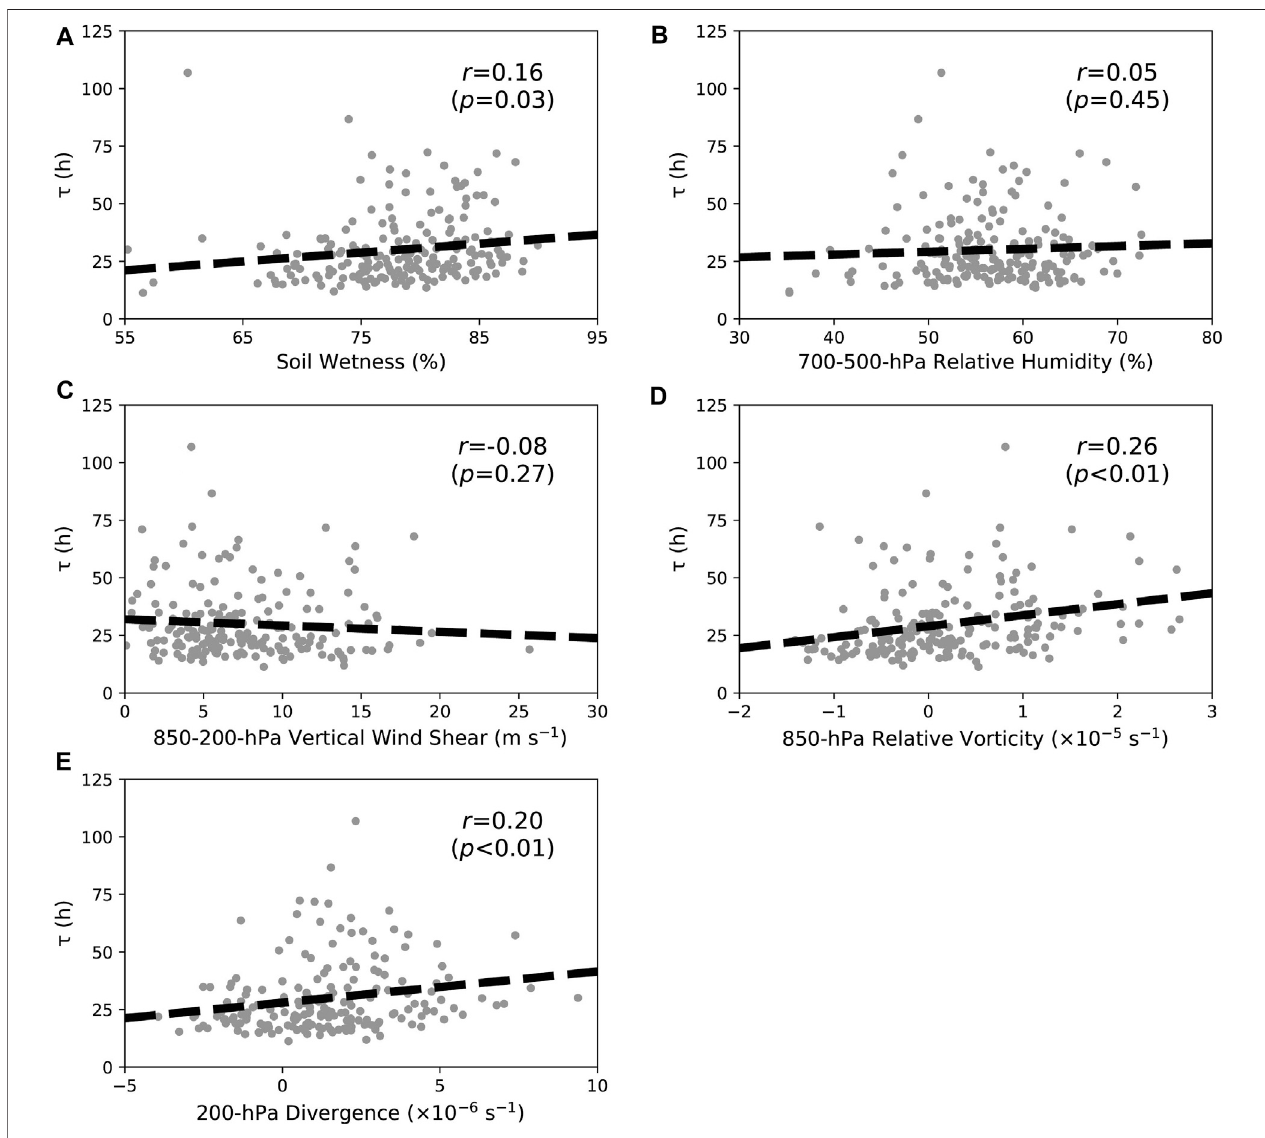
FIGURE 5 | Relationship between τ and fi ve environmental variables: (A) soil wetness, (B) 700 – 500-hPa RH, (C) 850 – 200-hPa VWS, (D) 850-hPa VOR and (E) 200-hPa DIV. The dashed lines are obtained by least squares, while the correlation coef fi cients and their signi fi cance levels are given in the panels.